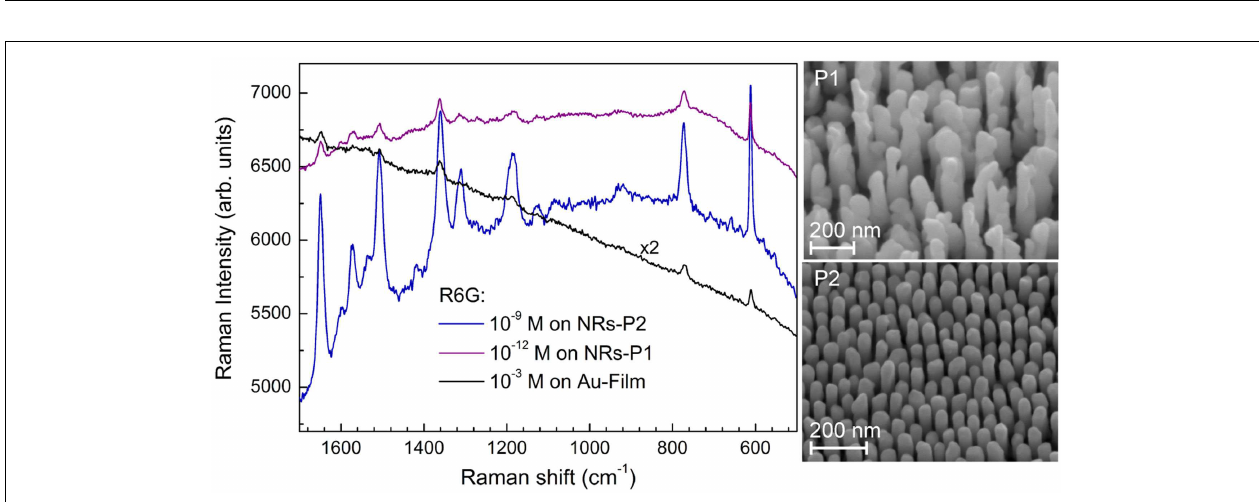
FIGURE 10 | SERS of rhodamine 6G (R6G) on supportedAg andAu-NRs (SEM micrographs are shown on the right-hand side) (Habouti et al., 2011a) .